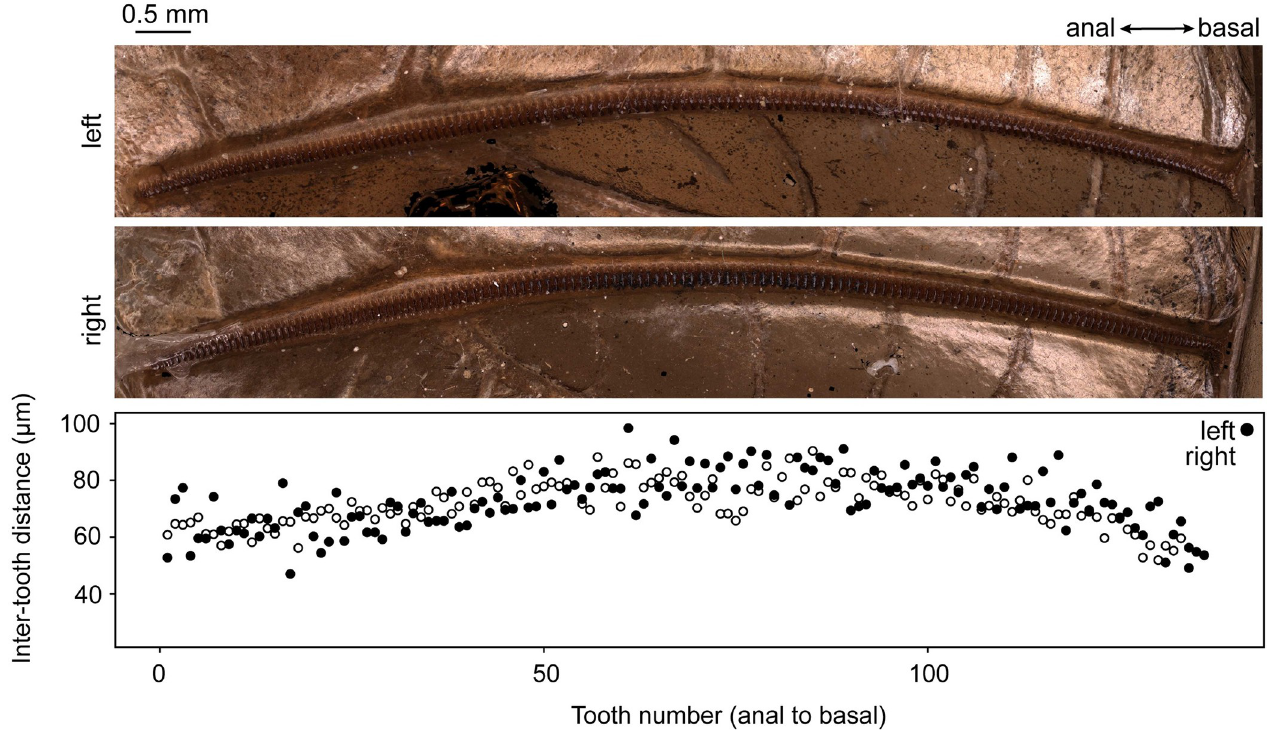
Fig 2. Stridulatory file anatomy and inter-tooth distances in Prophalangopsis obscura . Orientation of both files is along the anal (left) to basal (right) axis.